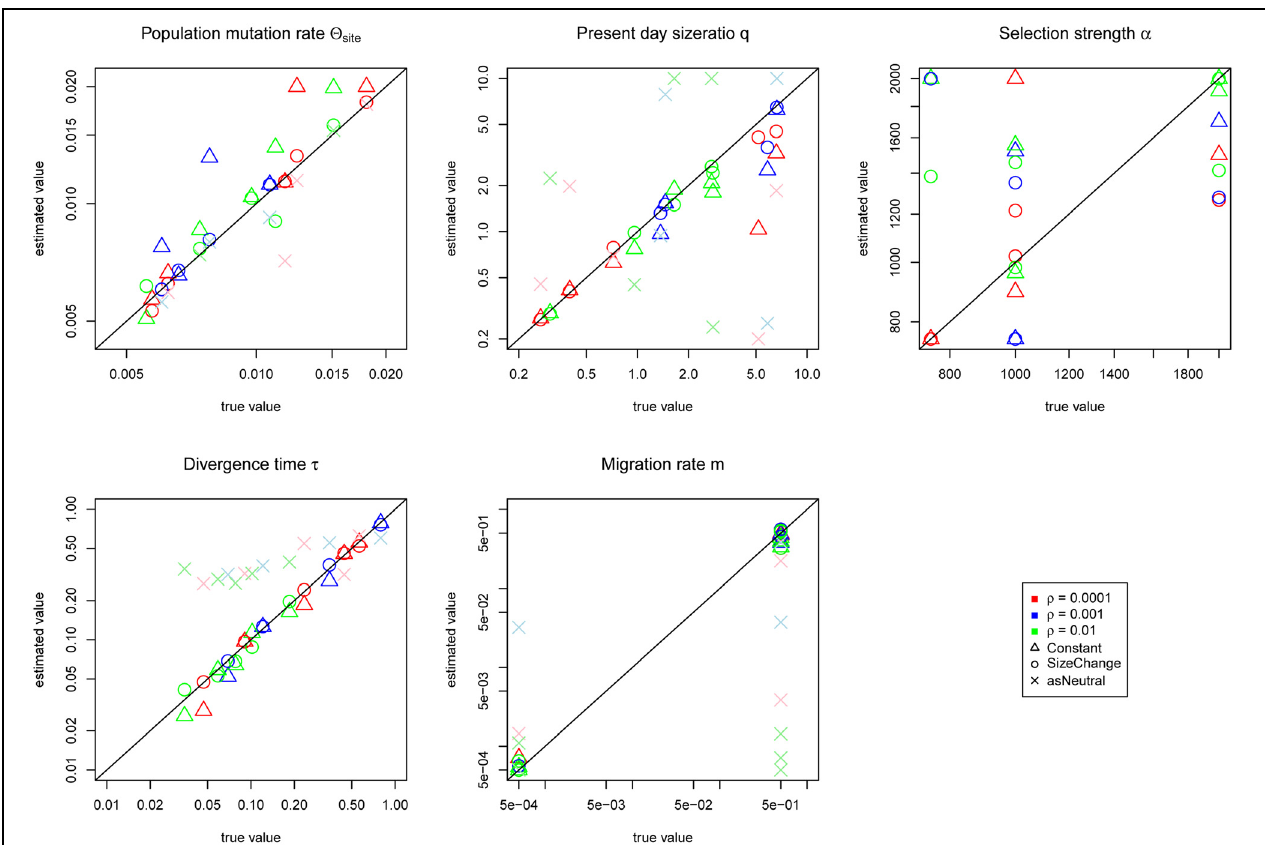
FIGURE 4 | Jaatha results of the simulation study under the complete sweep scenario for the Constant ( (cid:2) ) and the SizeChange ( o ) model. Data sets are color-coded according to their recombination rates per site of 10 − 4 (red), 10 − 3 (blue), and 10 − 2 (green). The results are plotted in the parameter ranges that were evaluated in Jaatha. The true value of the data sets produced with no migration were set manually to the lowest value of the parameter range. The demographic parameters are estimated accurately, however α is not. The divergence time of both populations (which also